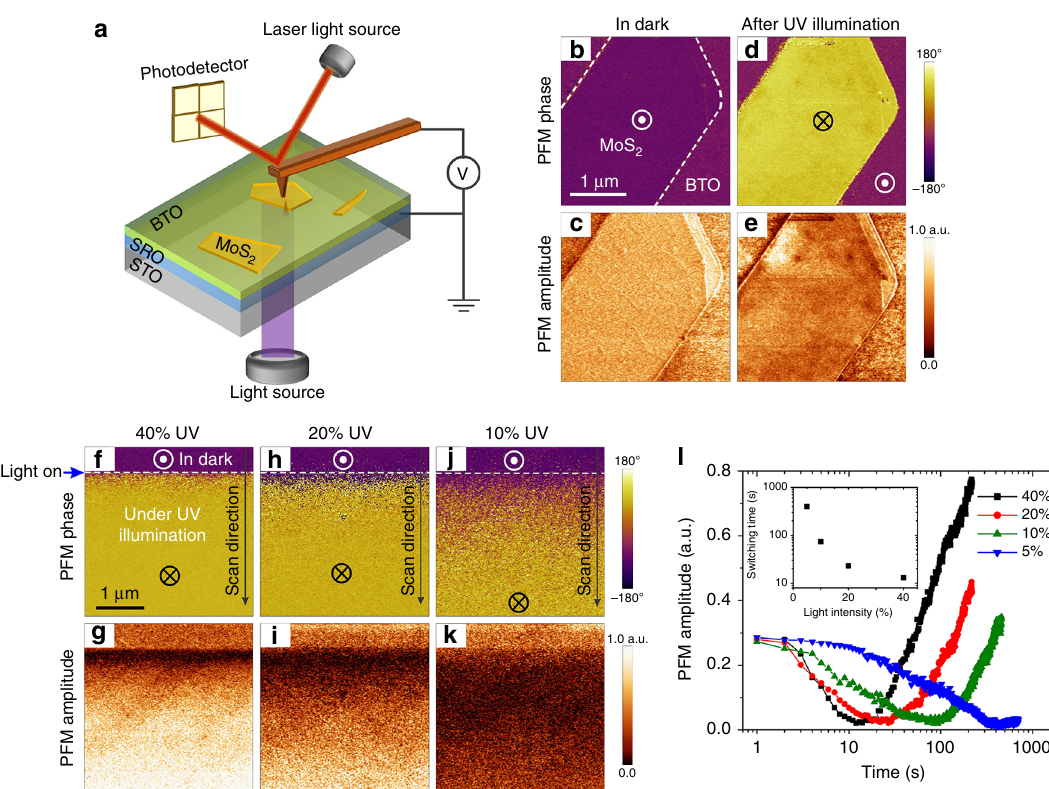
Fig. 2 Optically induced changes of the polarization in MoS 2 /BaTiO 3 /SrRuO 3 junctions. a A sketch of the experiment geometry. b – e PFM phase ( b , d ) and amplitude ( c , e ) images acquired in the dark before and after UV illumination. The MoS 2 fl ake boundary is indicated by the dashed lines in b . The BTO fi lm underneath MoS 2 was electrically poled to the upward polarization before illumination. f – k PFM phase ( f , h , j ) and amplitude ( g , i , k ) images under illumination with light of different intensity: f , g 40, h , i 20, and j , k 10% of the nominal light source power. The scanned area is fully covered by MoS 2 . Polarization was electrically switched in the dark to the upward polarization before each scan. l PFM amplitude signal as a function of time under illumination based on the analysis of the PFM images in g , i , k (PFM images for 5% light intensity are not shown). The minimum of PFM amplitude signal indicates an unpolarized state (likely due to the equal fraction of the upward and downward domains). The inset shows the optical switching time (de fi ned as a time required for the PFM amplitude to reach its minimum value after turning on the light) as a function of light